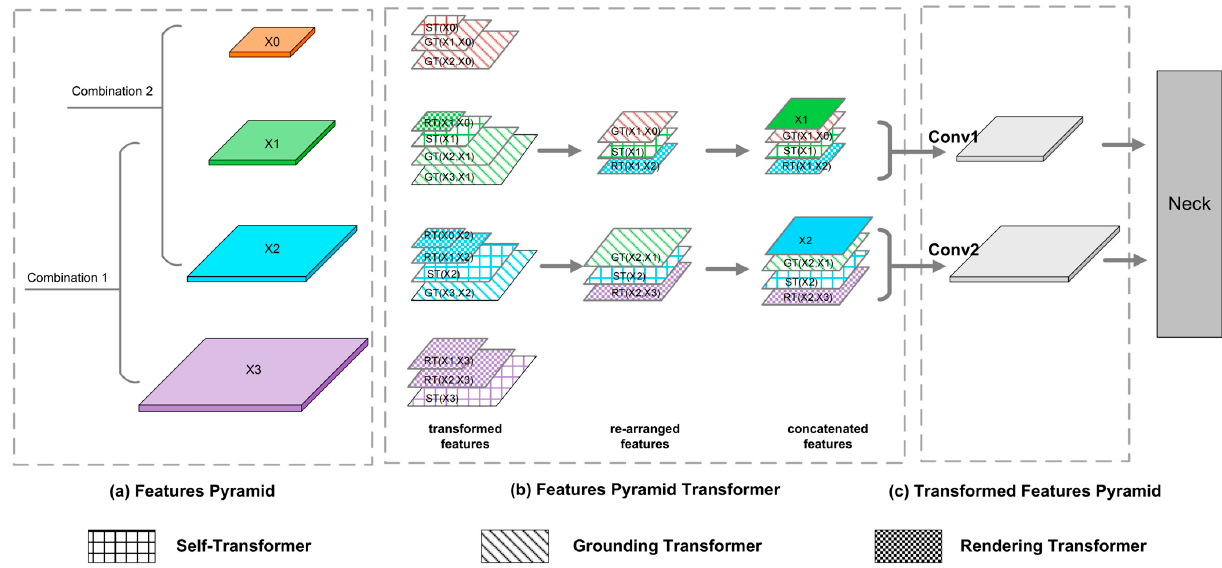
Figure 4. Improved structure of FPT modules. Different texture patterns represent different feature converters, and different colors represent feature maps of different scales. In order to describe the FPT module more succinctly, the outputs of blocks 7, 5, 3, and 2 are named X0, X1, X2, and X3. “Conv1” and “Conv2” on the right-hand side of the structure are 3 × 3 convolution modules with 192 and 96 output channels, respectively. ( a ) The FPT input is a feature pyramid consisting of two combinations. ( b ) FPT are the designs of three transformers ( c ) FPT output that controls the number of feature channels.